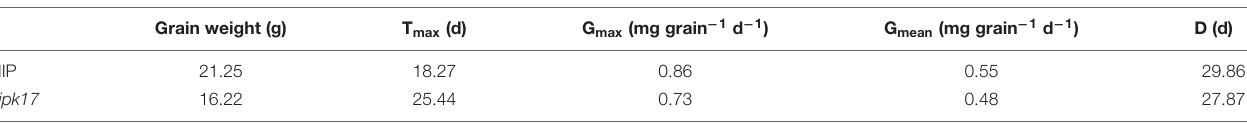
FIGURE 3 | OsCIPK17 can affect grain filling process and starch accumulation. (A) Grain-weight increasing dynamics curves of superior grains; (B) grain-filling rate curves of superior grains; (C) changes of PSII utilization efficiency (Phi2) of rice flag leaves at different growth stages. FTS, fully tillering stage; HFS, heading and flowering stage; LHS, the later heading stage. Phi2: PSII utilization efficiency. (D) Linear regression equation for starch content. (E) Determination of starch content in rice grains at mature. **** p < 0.0001, *** p < 0.001, ** p < 0.01, and * p < 0.05. TABLE 1 | Characteristic parameters of superior